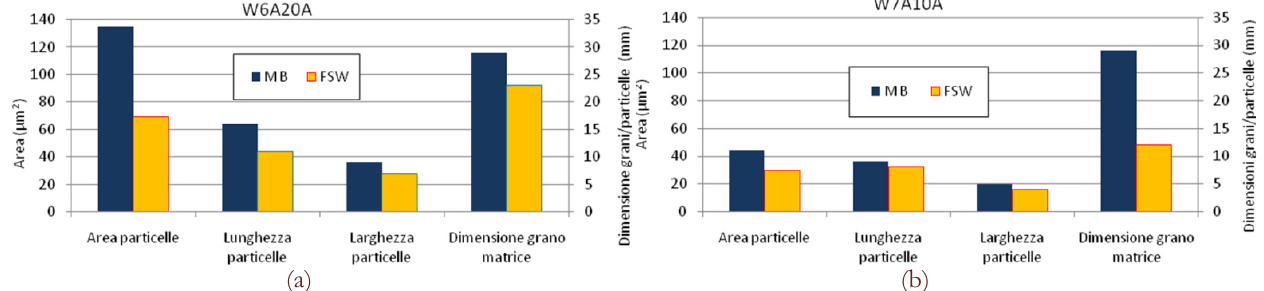
Figura 6: Confronto sulla dimensione delle particelle e sui grani della matrice di alluminio tra materiale base (MB) e giunti FSW per i compositi (a) W6A20A e (b)